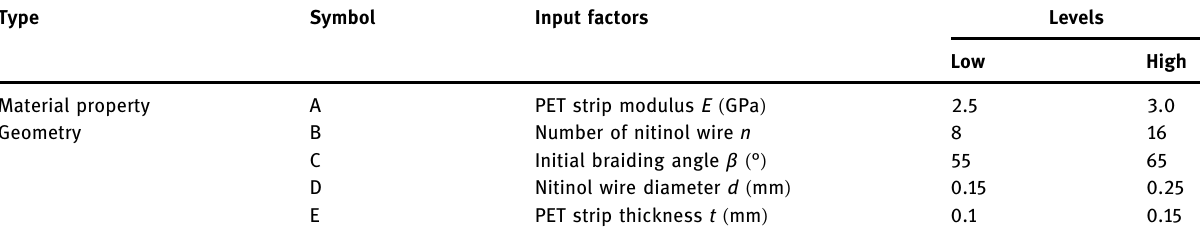
Table 1: Orthogonal experimental factors and levels